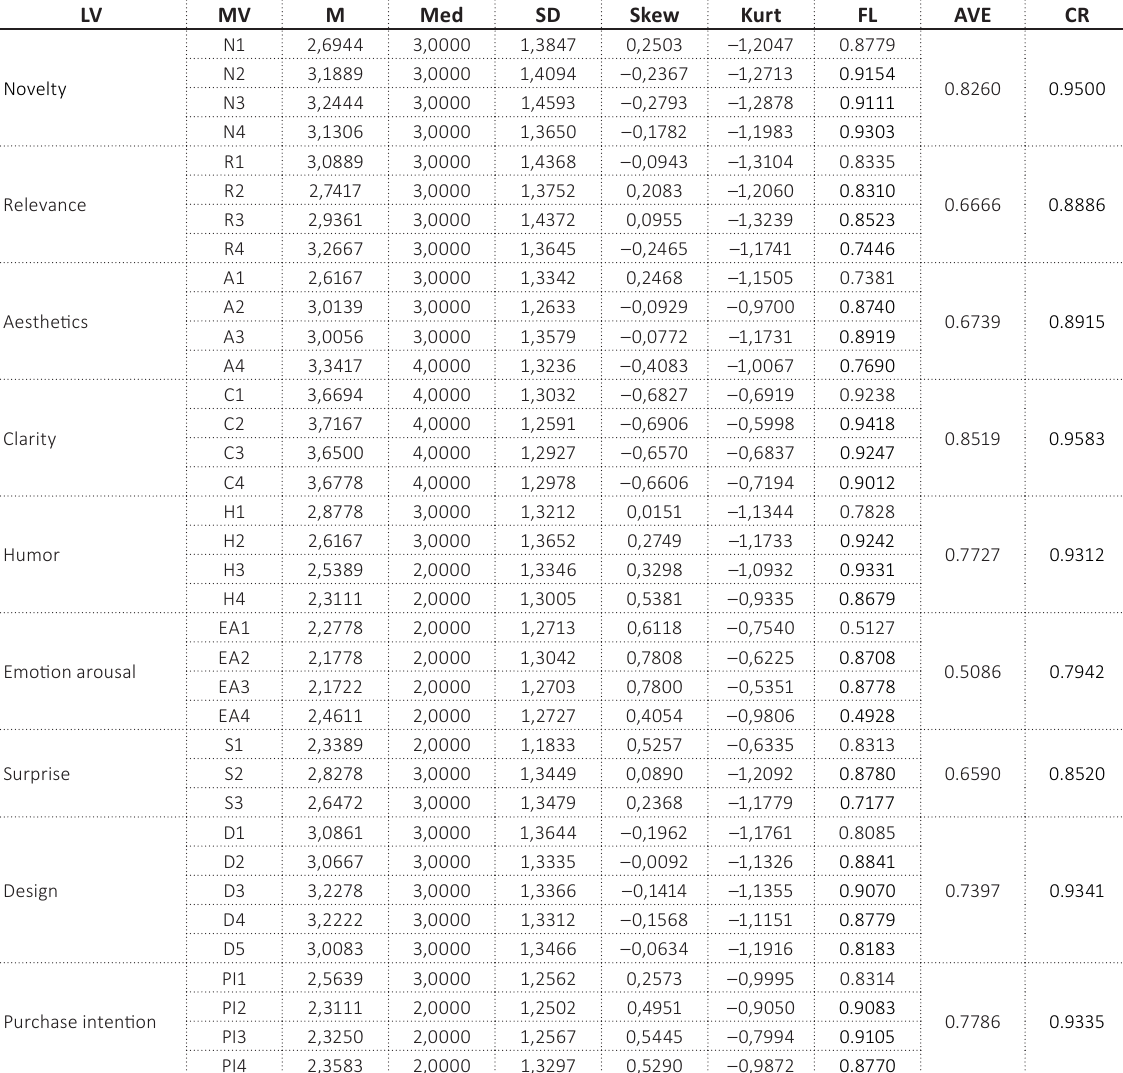
Table 3. Descriptive statistics and Confirmatory Factor Analysis